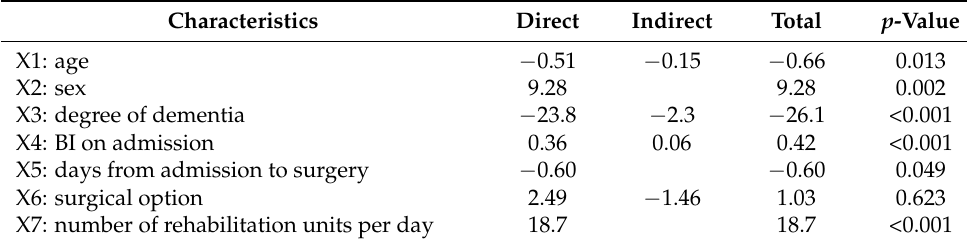
Table 4. Direct effect, indirect effect, total effect, and p